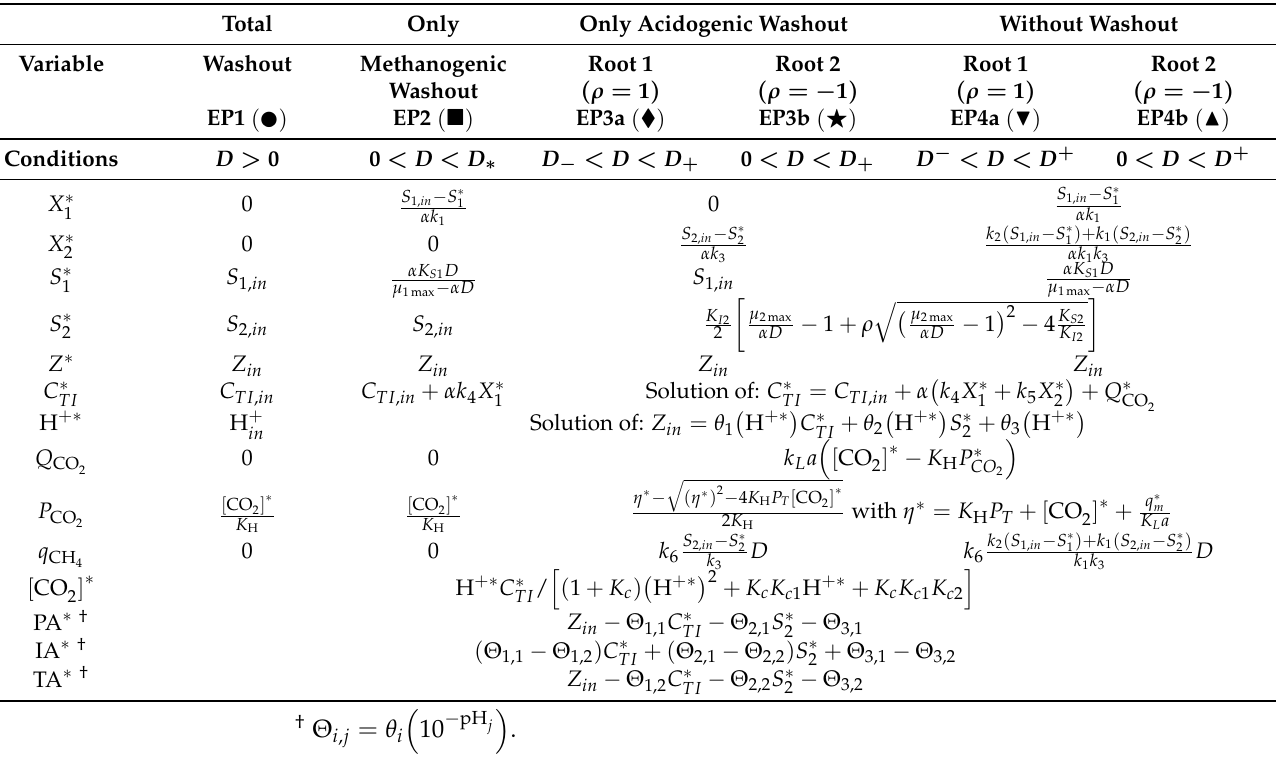
Table 1. Equilibrium